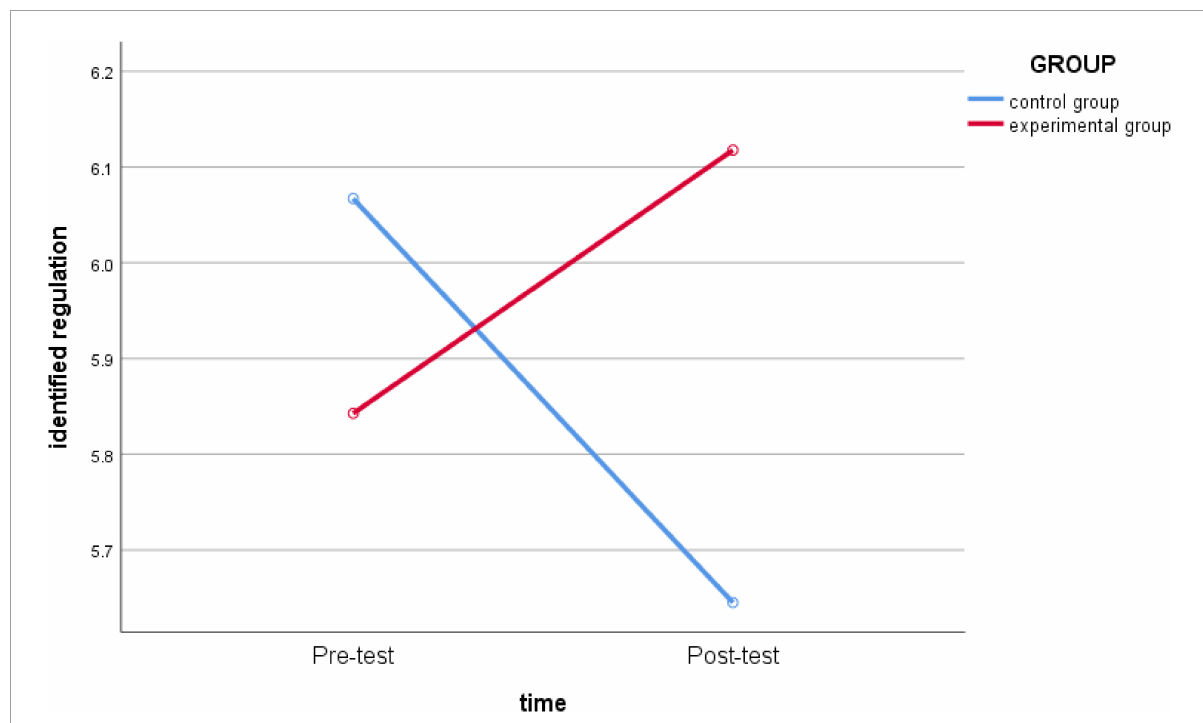
FIGURE6 Schematic diagram of the changes in identified regulation between the experimental group and the control group before and after intervention.